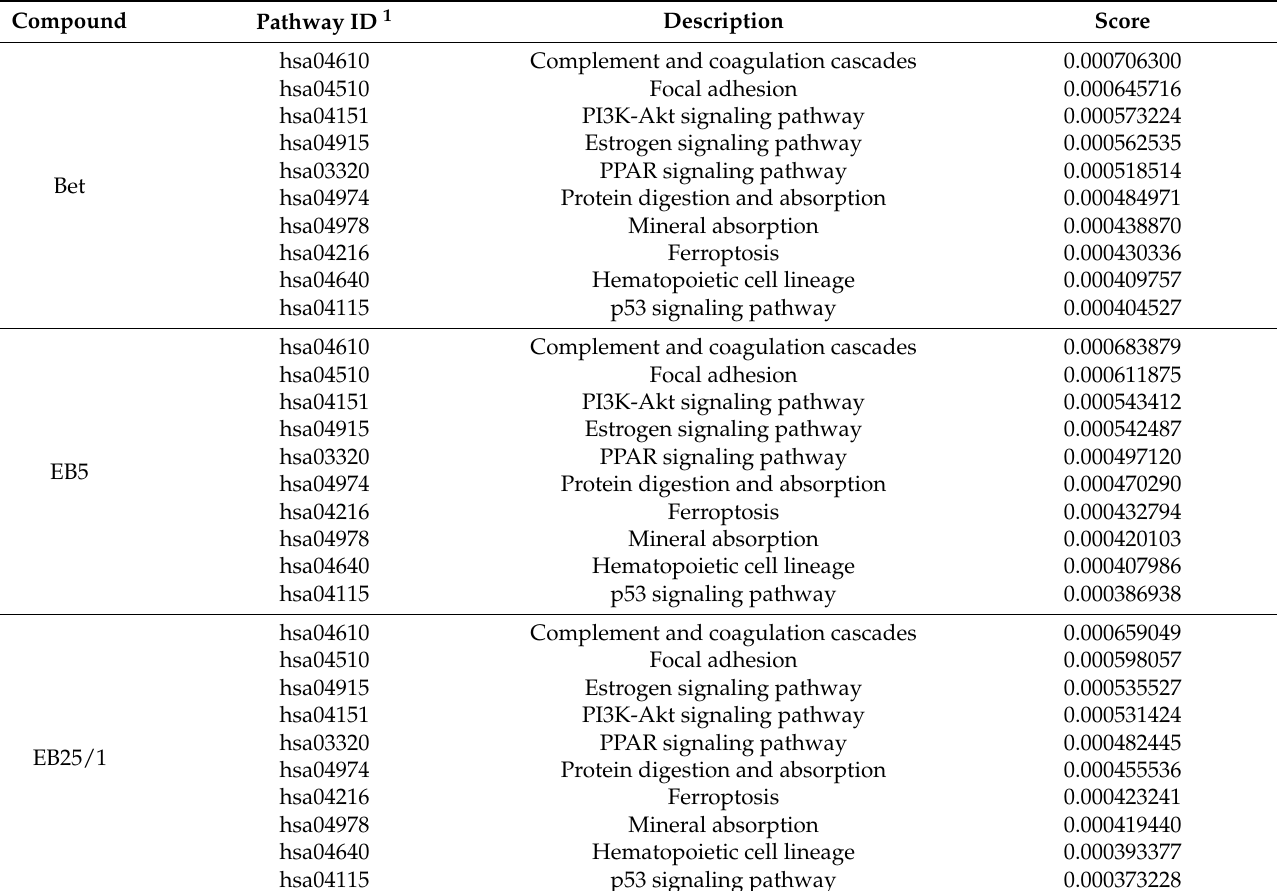
Table 6. Prediction of target pathways for ASBDs—in silico